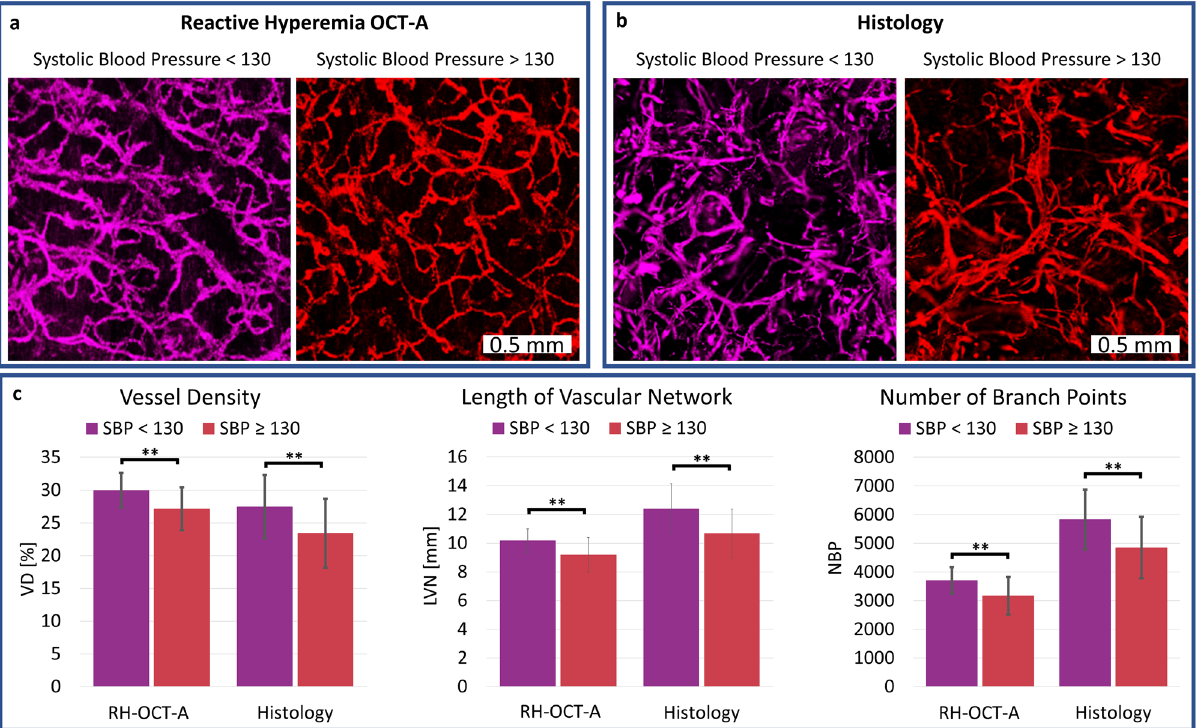
Figure 4. Comparison of RH-OCT-A images and equivalent horizontal histological images, both representing the microvasculature from a depth range of 40–440 µm of the upper dermis. Shown are two representative ( a ) RH-OCT-A images and ( b ) histology images: colored in purple is a subject with normal blood pressure and colored in red is a subject with high blood pressure. ( c ) Quantification of vessel density (VD), length of the vascular network (LVN), and number of branch points (NBP) for normal and high blood pressure subjects of RH-OCT-A images and histology images. ** p < 0.01. Values represent the mean value and the standard deviation of the mean from 2 RH-OCT-A images and 2 histological images obtained for each subject (SBP < 130: n = 15; SBP ≥ 130: n =